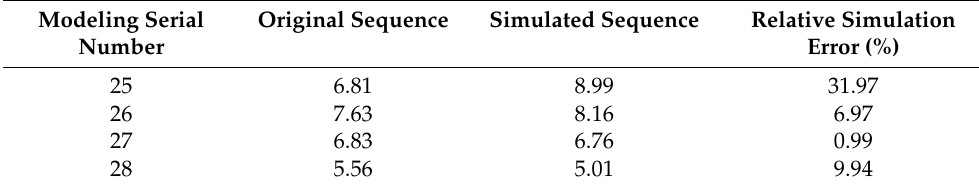
Table 8. The prediction results of absolute dry compressive strength.